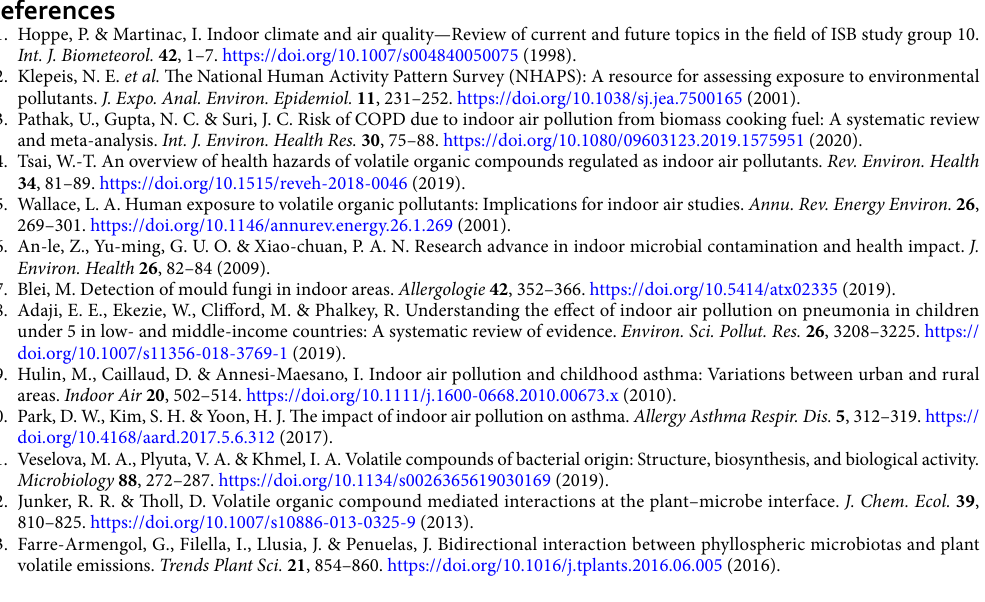
2 (PICRUSt2) was used to predict the KEGG category based on 16Sr DNA of samples 63